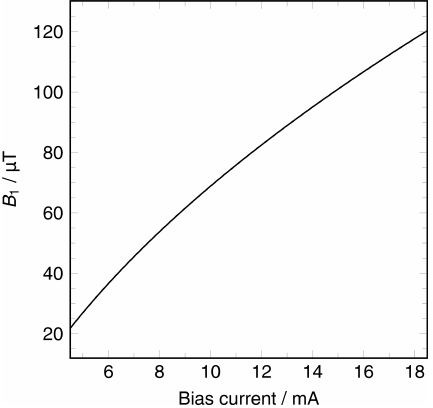
Figure E1. B 1 magnitude obtained by the square-root model of the bias current used throughout the EPRoC experiments reported in this